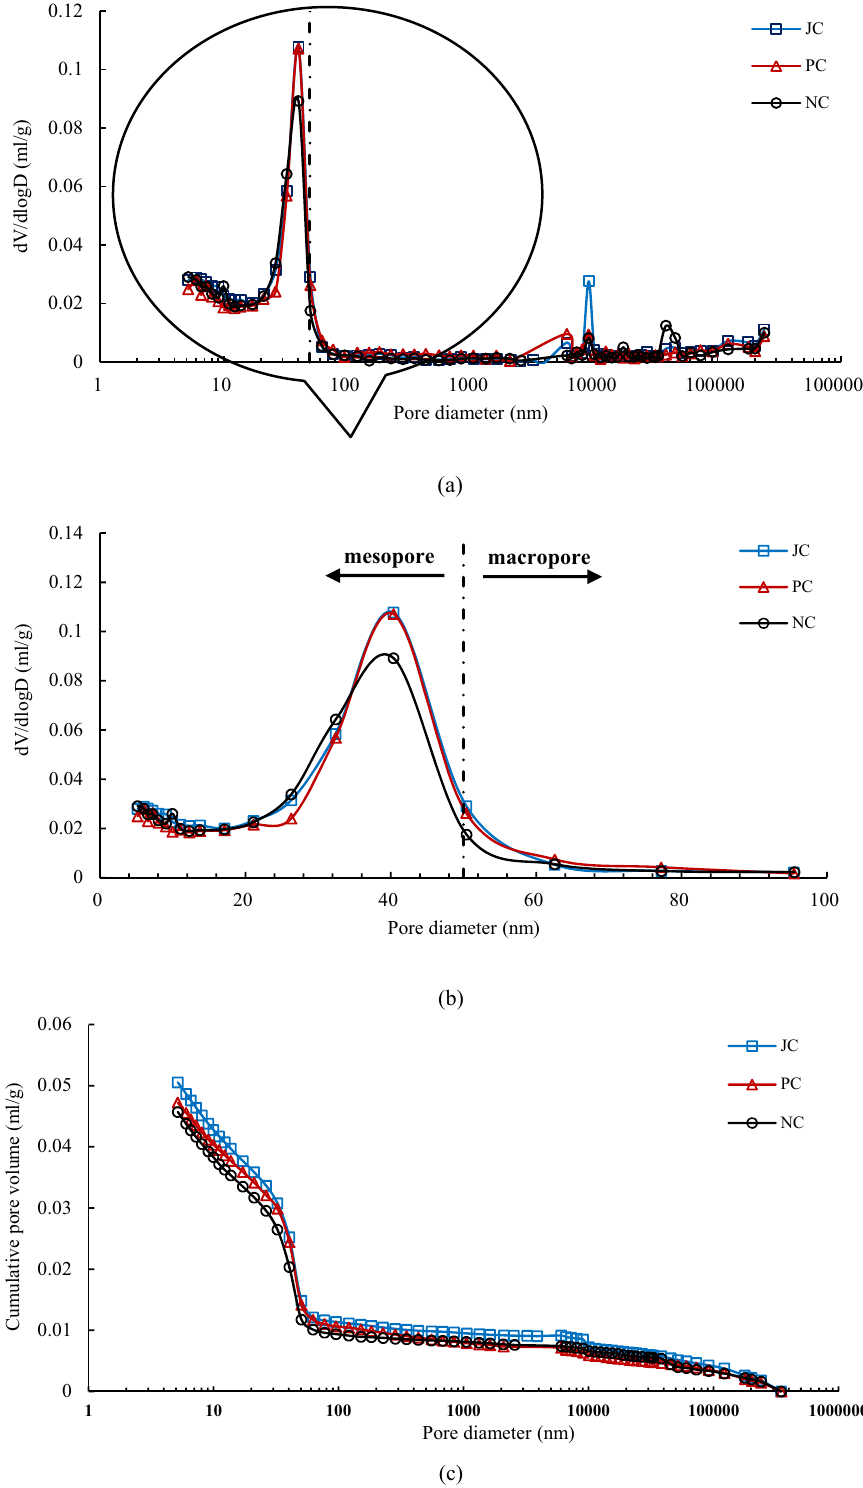
Figure 11: Pore size distribution and cumulative pore volume of JC, PC, and NC at 28 days: ( a ) pore size distribution, ( b ) enlarged pore size distribution, and ( c ) cumulative pore